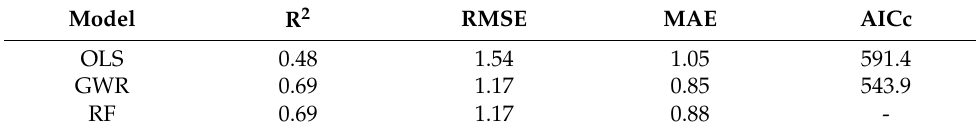
Table 7. Model fitness test of the statistical models and machine-learning model. Model R 2